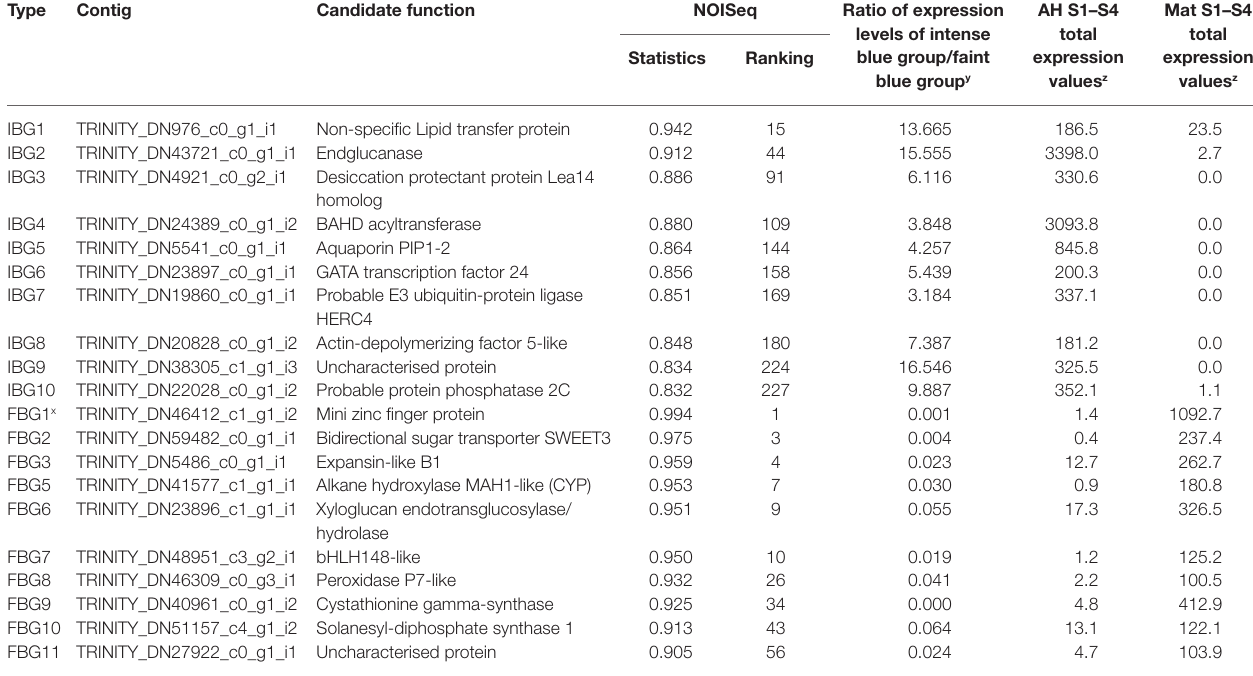
TABLE 1 | List of the top 10 DEGs [intense-blue genes (IBGs) and faint-blue genes (FBGs)].